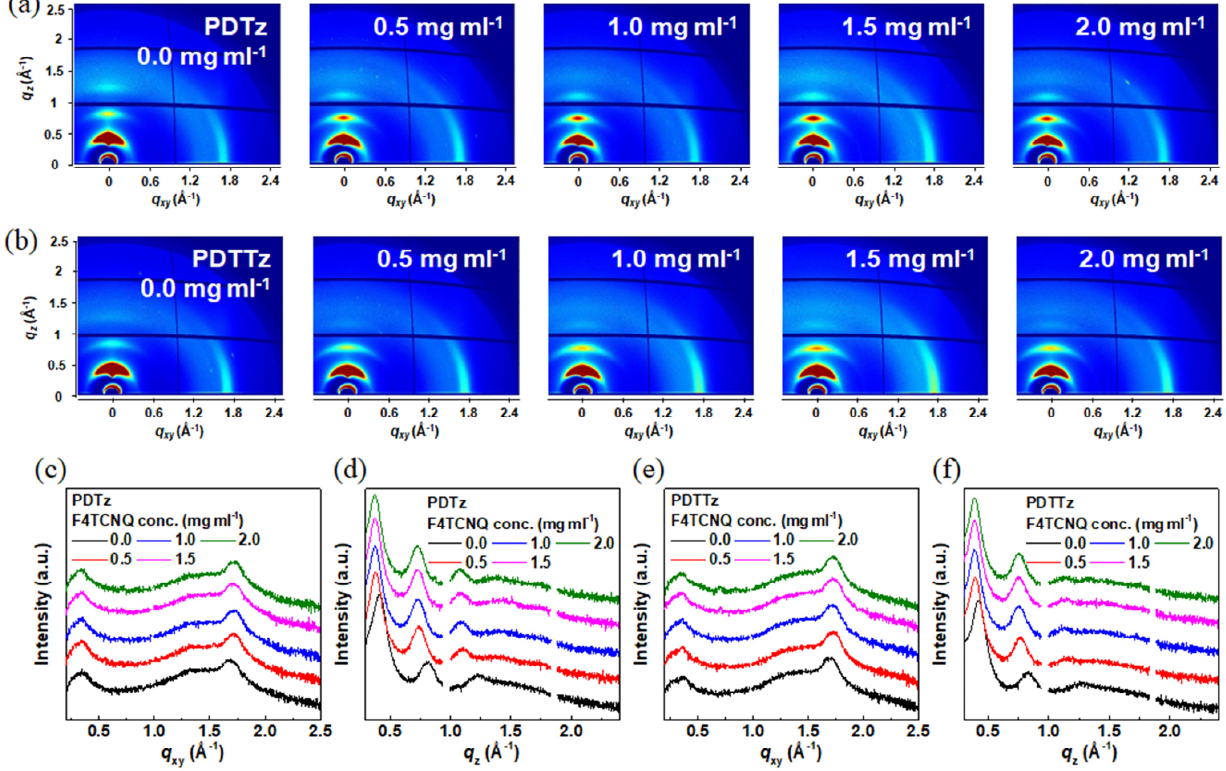
Asterisks denote a new transition that increases with F4TCNQ doping ratio. Asteri s ks denote a new transition that increases with F4TCNQ doping ratio.